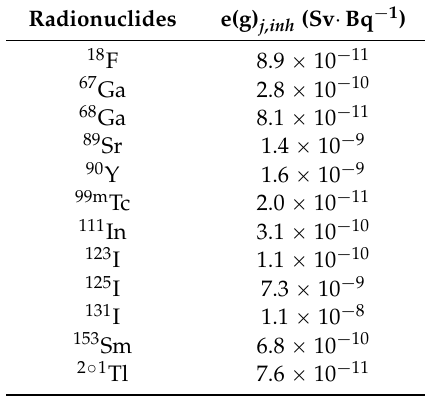
Table 1. Dose coefficients for inhalation of 5 µ m aerosols by workers (Sv ¨ Bq ´ 1 ) for the commonly handled radionuclides given by ICRP Publication No. 68